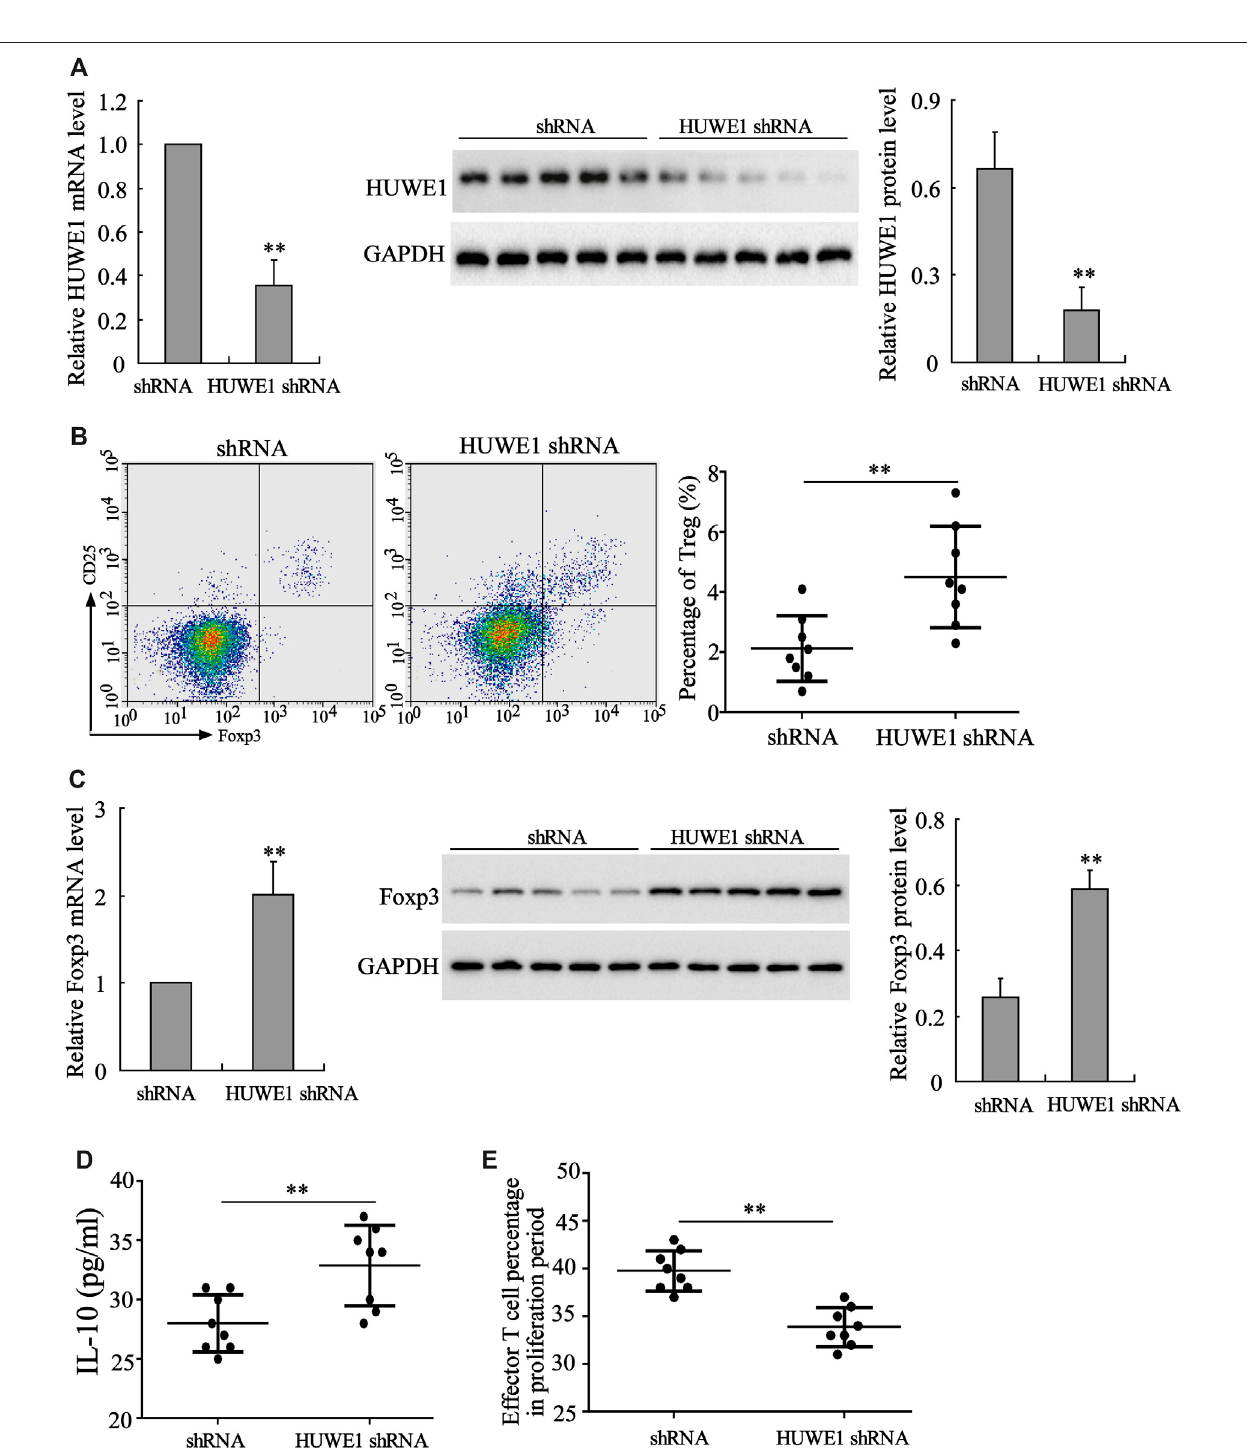
FIGURE2| In fl uenceofHUWE1onTregcellpercentage,Foxp3expression,IL-10productionandTregcellimmunosuppressivefunction.CD4 + Tcellsinperipheral blood from ITP patients were transfected with HUWE1 shRNA for 96 h. (A) Analysis of the HUWE1 mRNA and protein levels using qRT-PCR and Western blot; and the quantitative analysis of HUWE1 protein level (mean ± SEM, n (cid:2) 5). (B) Flow cytometry was conducted to analyze the percentage of Treg cells in CD4 + T cells (mean ± SEM, n (cid:2) 8). (C) qRT-PCR and Western blot were performed to quantify the mRNA and protein levels of Foxp3 in CD4 + T cells; and the quantitative analysis of Foxp3 protein level (mean ± SEM, n (cid:2) 5). (D) Enzyme-linked immunosorbent assay (ELISA) was applied to detect the concentration of IL-10 in CD4 + T cell culture supernatant (mean ± SEM, n (cid:2) 8). (E) Treg cells from ITP patients were transfected with HUWE1-interfering lentivirus (HUWE1 shRNA) and then cultured with effector T cells in a ratio of 1:4. Immunosuppression assay was performed to analyze the inhibitory effect of Treg cells on the proliferation of effector T cells (mean ± SEM, n (cid:2) 8). ** p < 0.01 vs. shRNA. The experiment was repeated three times.